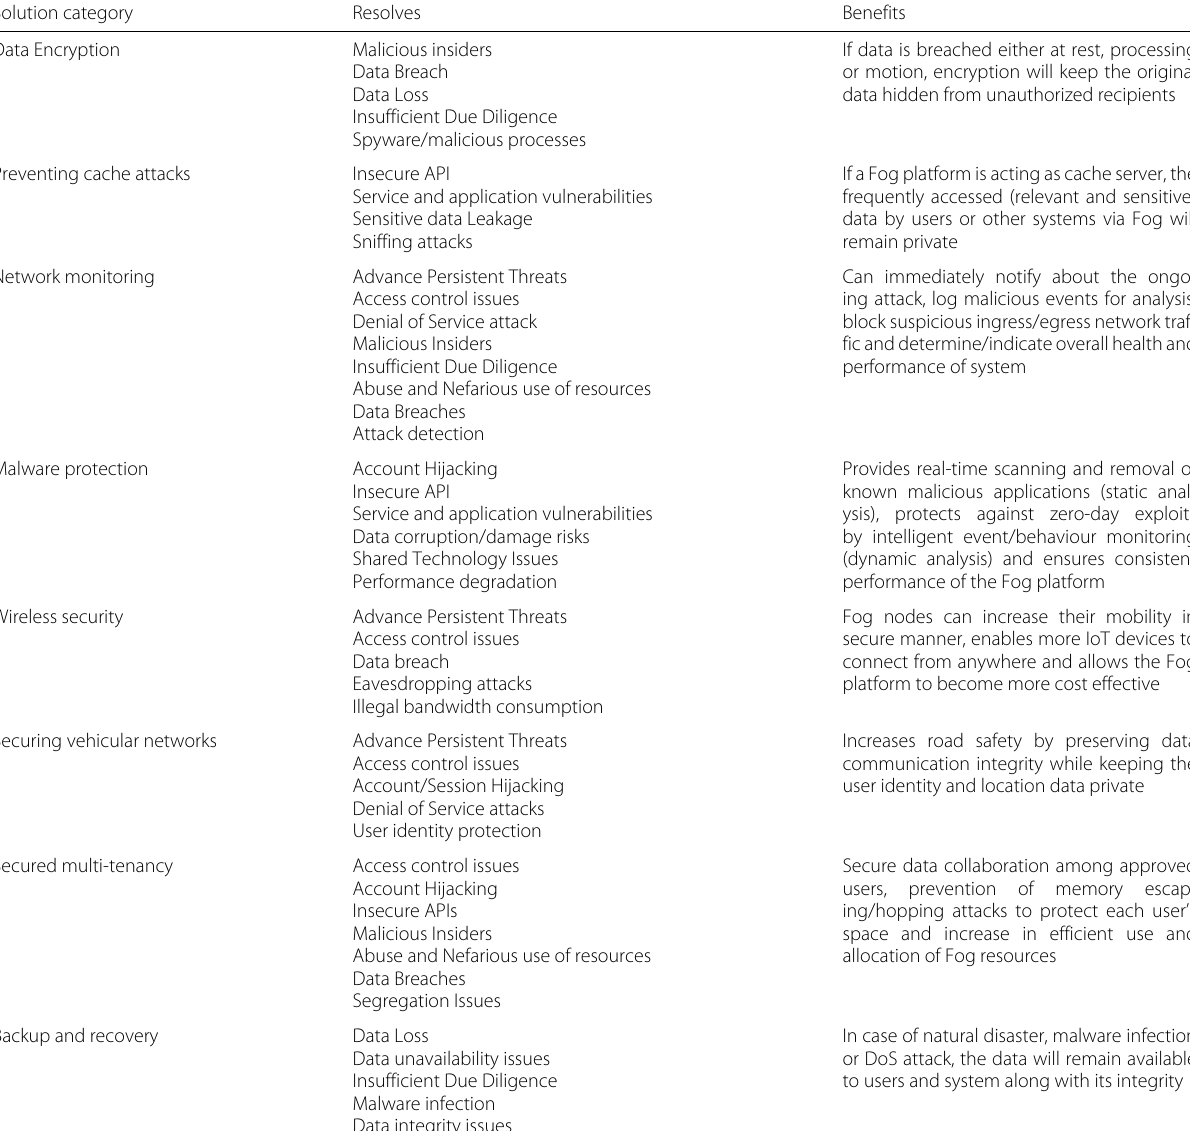
Table 4 Summary of recommended security solutions and impact on CIA Solution